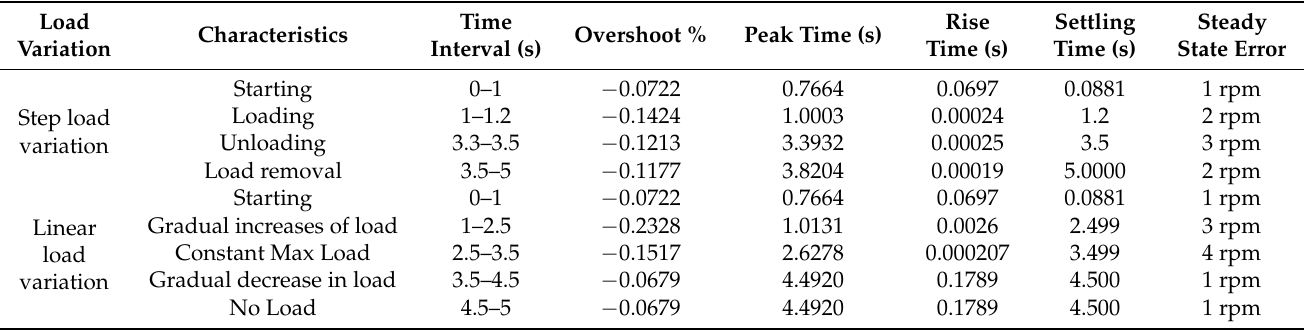
Table 3. Fuzzy Controller